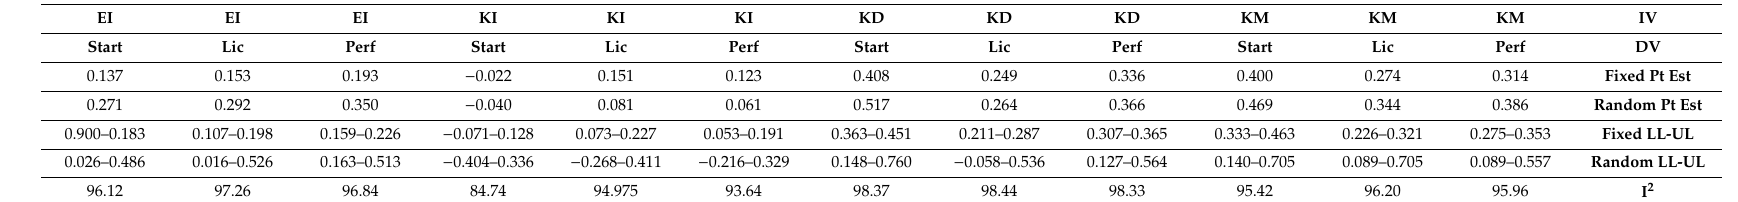
Table 6. University technology transfer meta-analysis results comparing the fixed e ff ects model and a random e ff ects